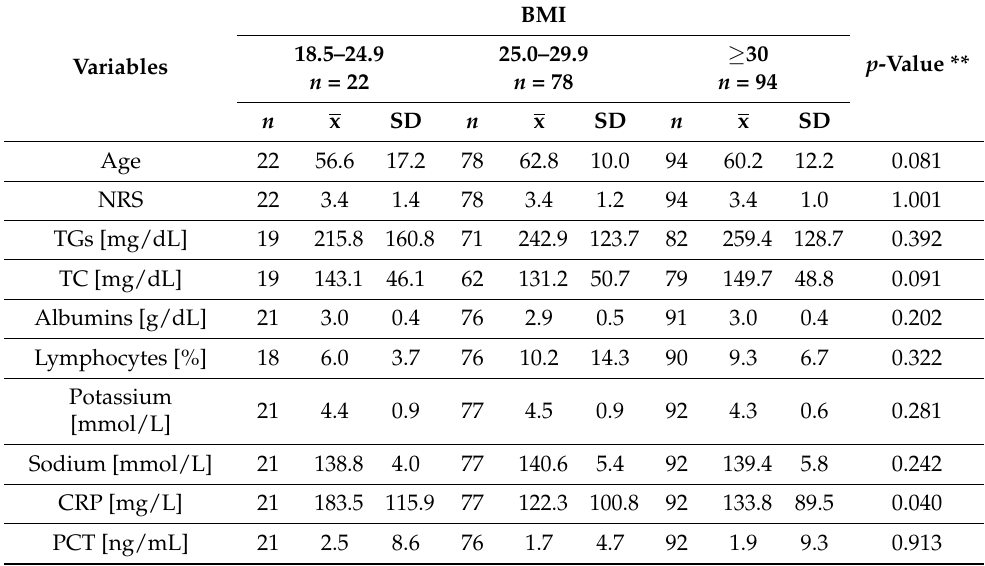
Table 3. Comparison of assessed parameters (quantitative variables) and BMI range (WHO criteria)